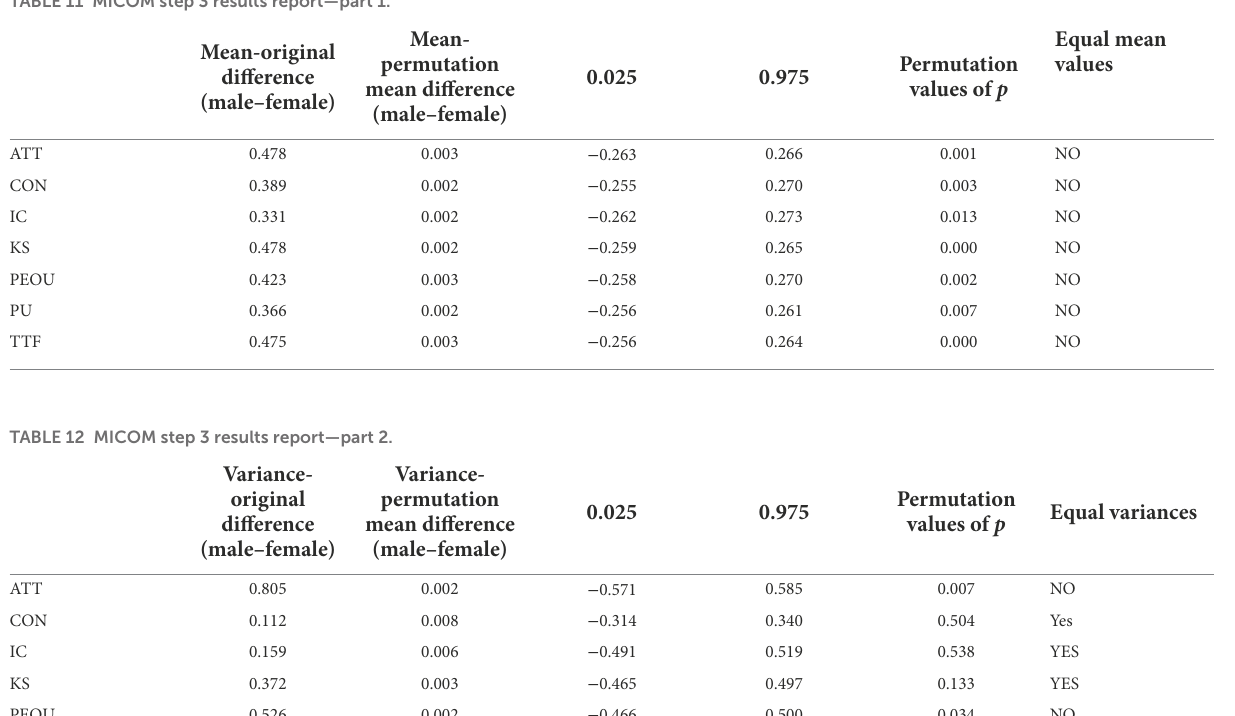
TABLE 11 MICOM step 3 results report—part 1.